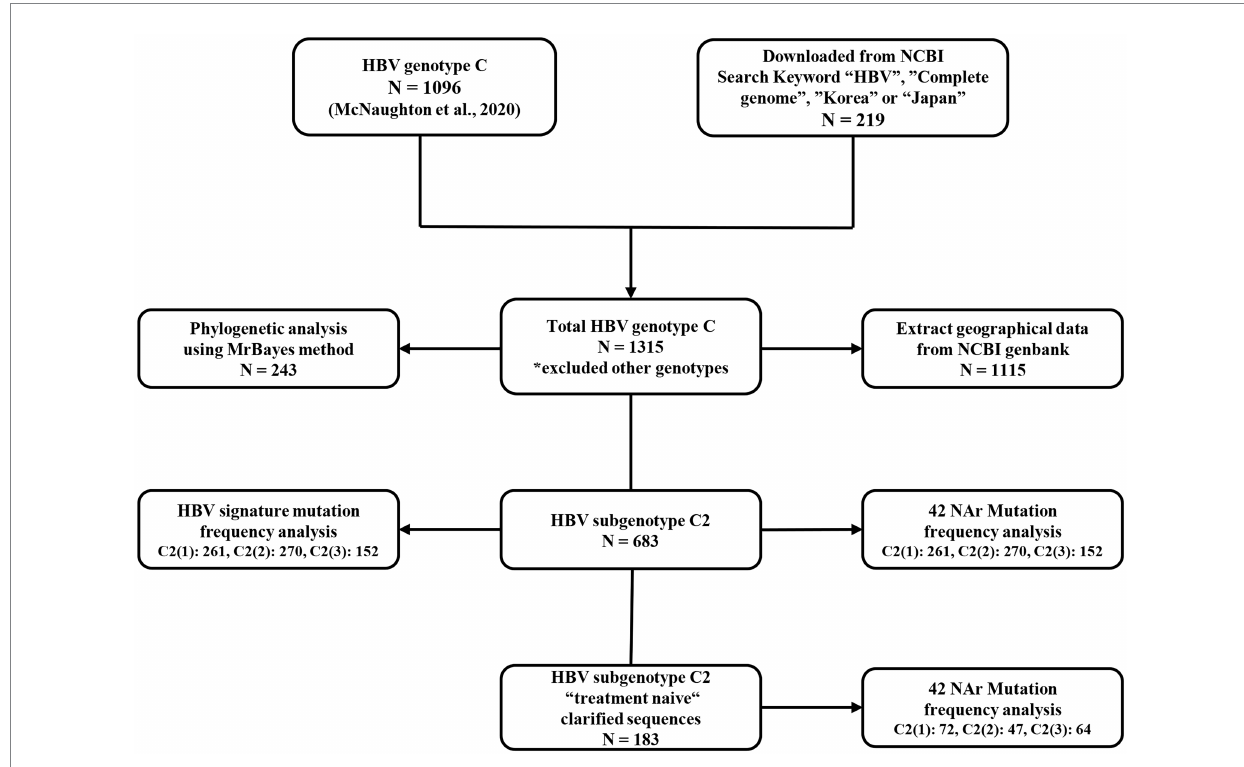
FIGURE 1 Flowchart of dataset preparation and data composition for each